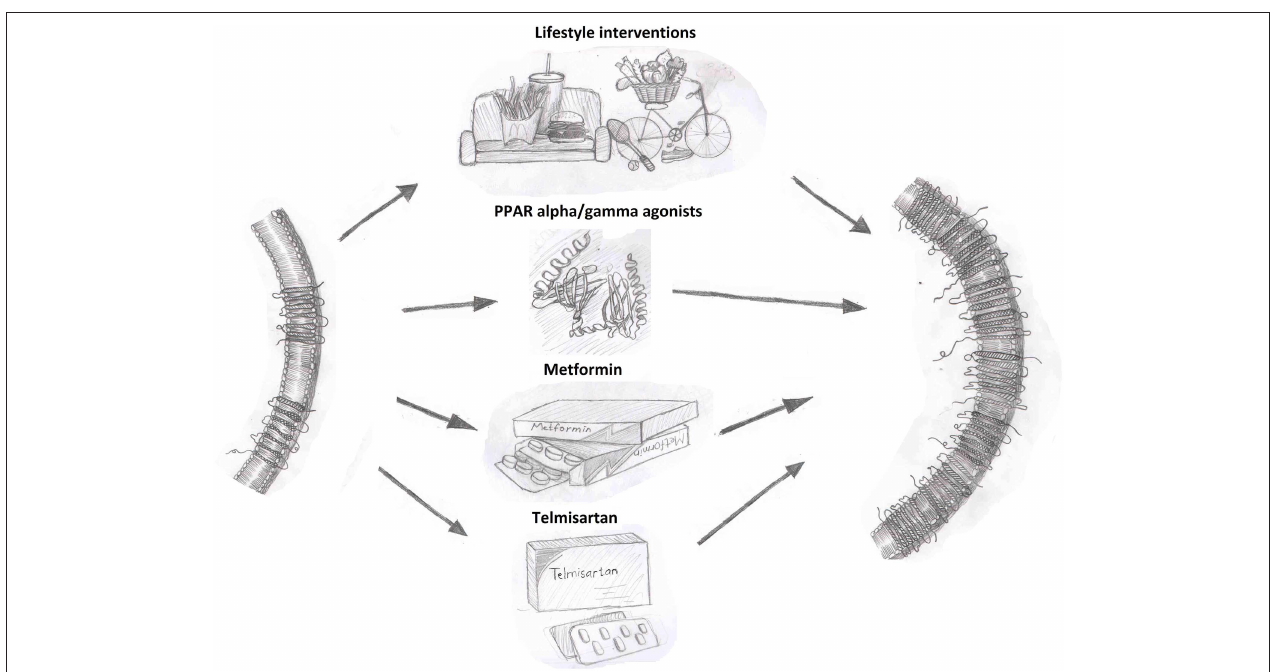
FIGURE 1 | Interventions that enhance adiponectin receptor expression. Adiponectin receptor expression can be increased by lifestyle interventions, such as diet and exercise as well as through pharmacological therapies as shown.